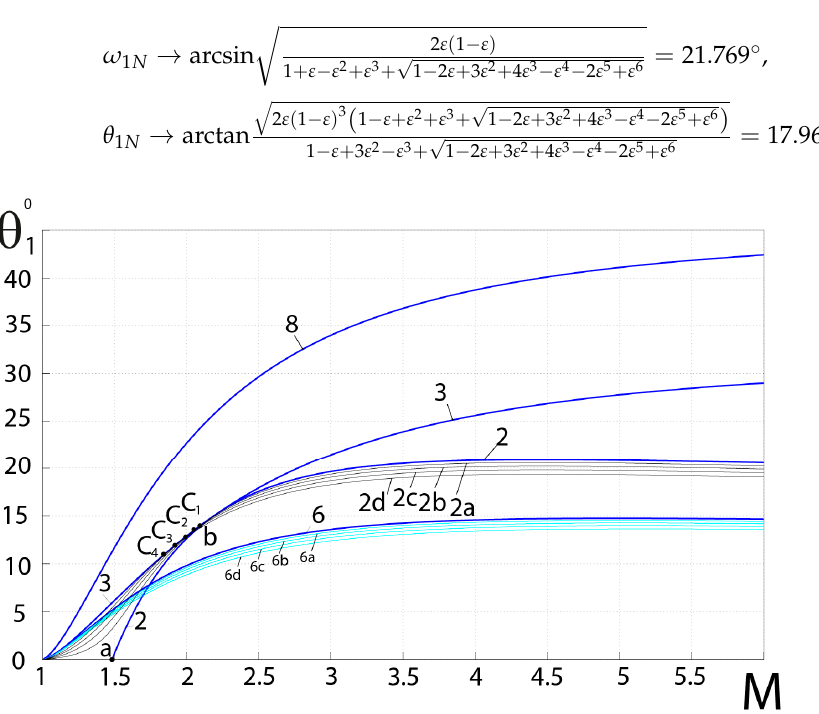
Figure 5. Flow deflection angle at special incident shocks. As in Figure 3, curve 2 corresponds to von Neumann criterion, curve 3 corresponds to detachment criterion, curve 6 corresponds to incident shocks forming SMCs at maximum pulsed energy release, and curve 8 corresponds to critical flow velocity after the incident shock. Curves 2a–d and 6a–d describe the variation of incident shock features when the adiabatic index changes at the main shock. Points c 1 - c 4 demonstrate the shift of Mach number M b of coincidence of the reflection type criteria.